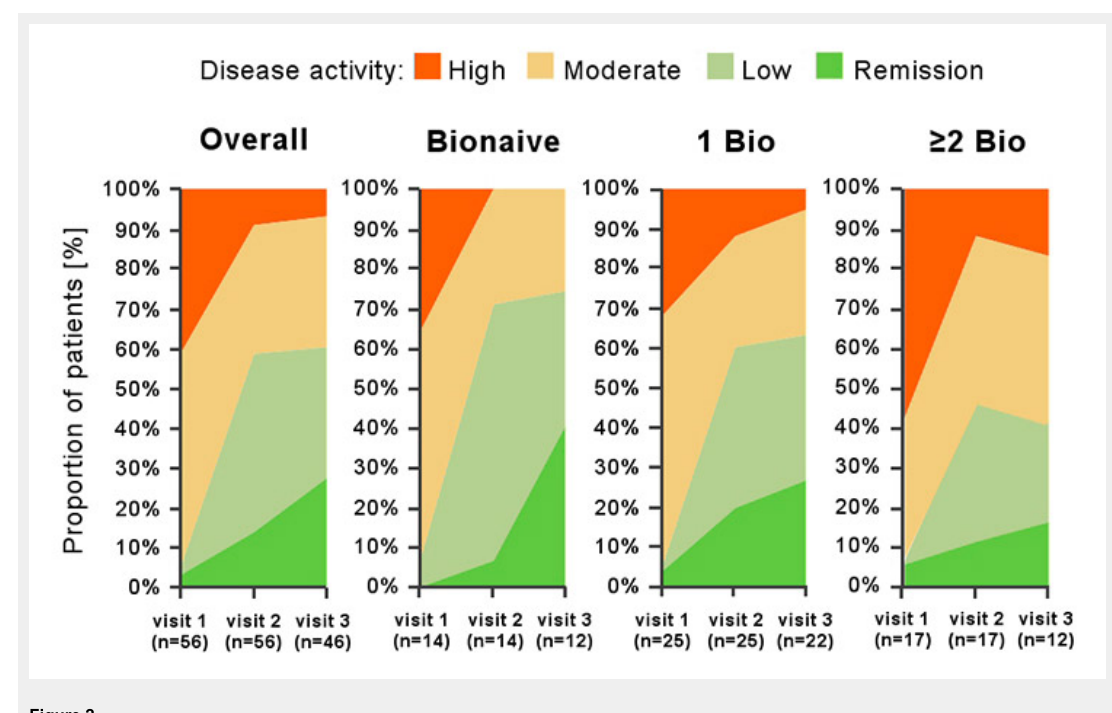
Figure 2 Disease state over time as assessed by physicians shown for the overall population, for biologic-naïve patients, and for patients with one (1 Bio) or at least two (≥2 Bio) previous biologics. Numbers in brackets indicate the numbers of patients (n) with available physicians’ assessment at each